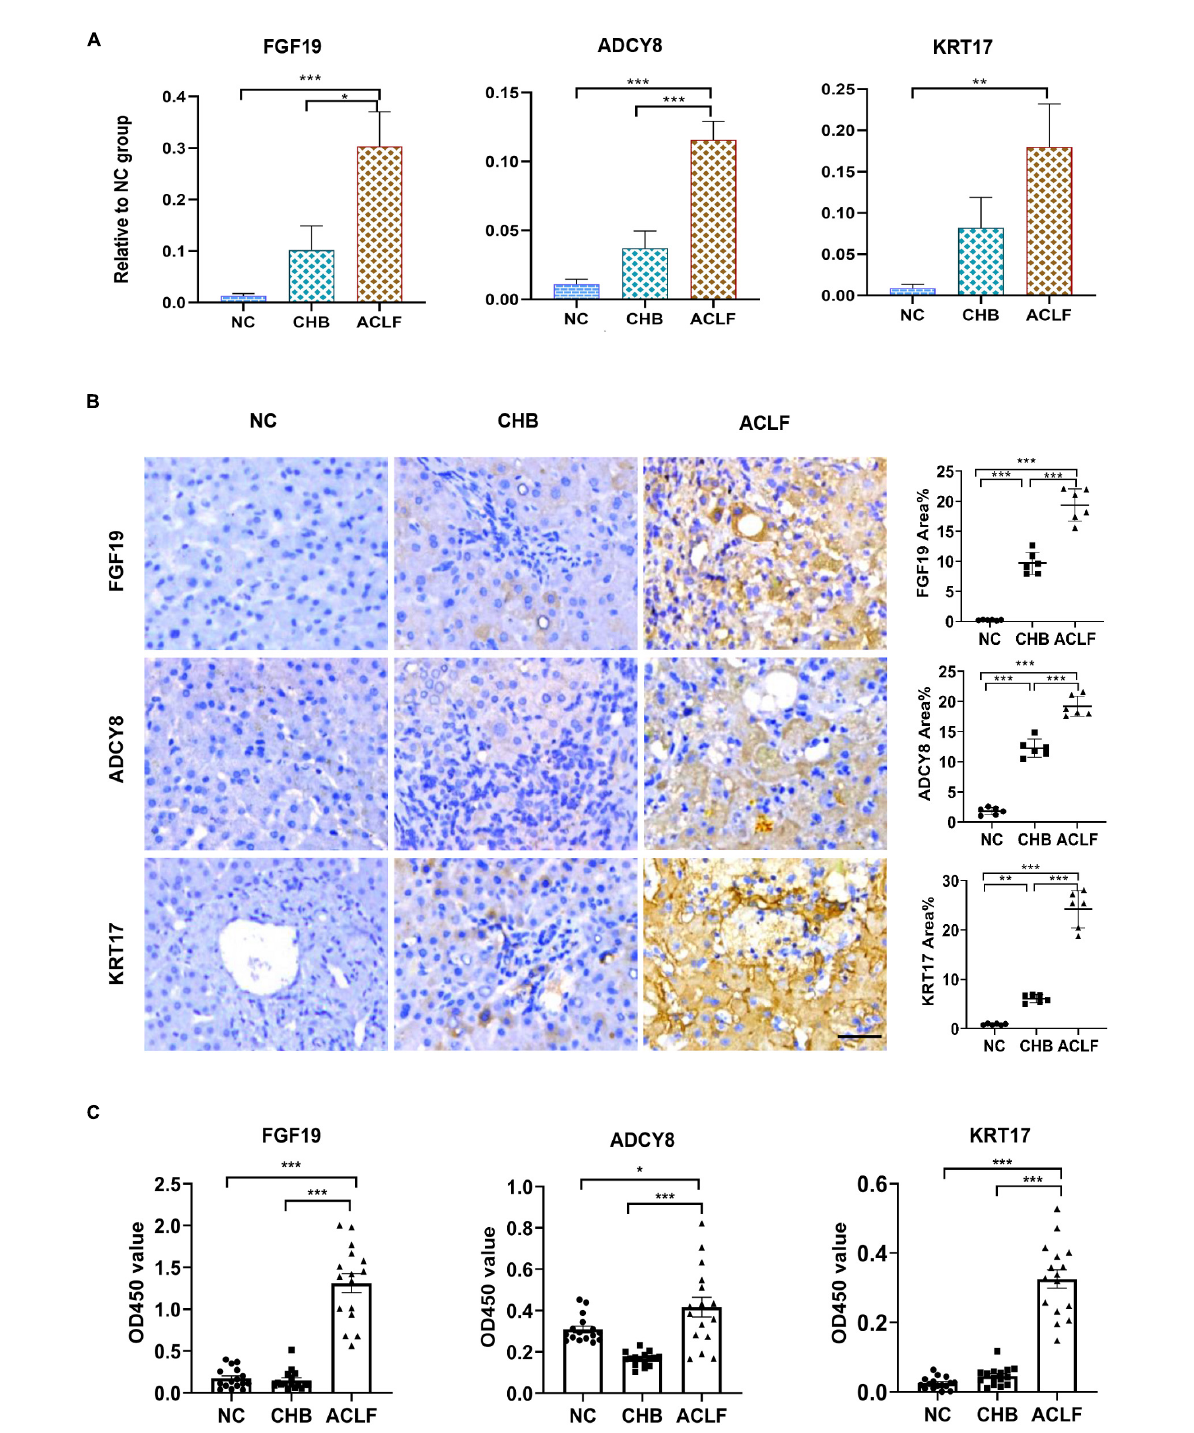
FIGURE5 External validation by qRT-PCR and IHC staining in amplified human samples. (A) qRT-PCR validation of three genes ( n = 10/10/10, NC/CHB/ACLF groups). (B) IHC and quantification of three key proteins involved in immunometabolic disorder in patients in the NC, CHB and HBV-ACLF validation cohort (bar = 50 µ m ). (C) Content of three markers in human serum ( n = 16/16/16, NC/CHB/ACLF, respectively). The values are presented as the means ± SEMs. *Adjusted p < 0.05, **Adjusted p < 0.01, ***Adjusted p < 0.001. HBV, hepatitis B virus; ACLF, acute-on-chronic liver failure; CHB, chronic hepatitis B; NC, normal control; FGF19, fibroblast growth factor 19; ADCY8, adenylate cyclase 8; KRT17, keratin 17; IHC,